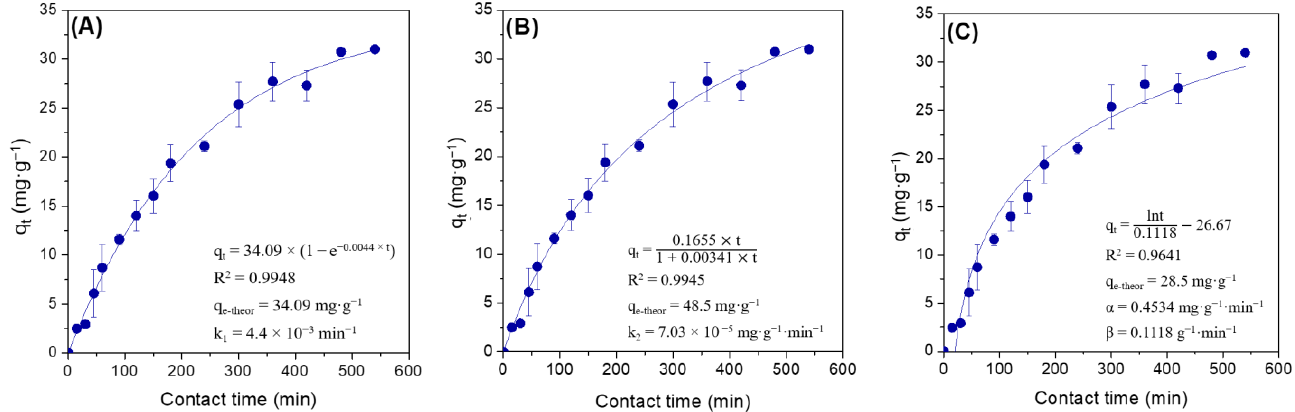
Figure 1. Non-linear adsorption kinetic models of ( A ) pseudo-first-order; ( B ) pseudo-second-order; and ( C ) Elovich plots for the adsorption of lipase Eversa ® Transform 2.0 on PSty-DVB beads at 25 °C, 200 rpm, and pH 5.0 (buffer sodium acetate at low ionic strength — 5 mmol·L − 1 ), using an initial protein loading of 40 mg·g − 1 of support.